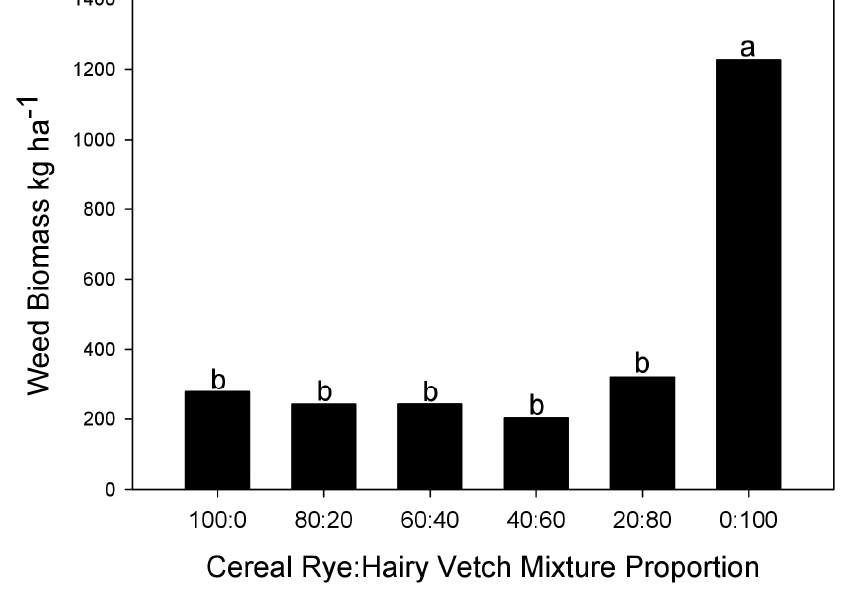
Figure 5. Weed biomass at corn silking over the 2013–2014 growing seasons under different cereal rye/hairy vetch mixture proportions (data from the Agricultural Research Center, Beltsville, MD, USA). Different letters above bars show significant differences ( F 5,18 = 4.57, p < 0.01).